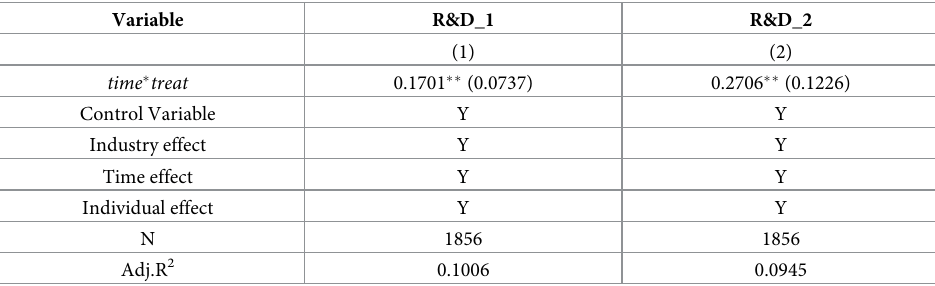
Other robustness tests. There is a large variability in R&D investment among different enterprises, and the overall distribution is right skewed. To reduce the interference of this biased distribution on the results, this paper uses a negative binomial distribution regression to re-estimate the impact of CEO awards on R&D investment. The regression results are reported in columns (1) and (2) of Table 12. We find that the research conclusions of this paper remain valid after considering the right-sided distribution of R&D investment. Further, this paper sets four dummy variables and examines the changes in the R&D investment of enterprises before and after CEOs in the industry receives awards. Ind _ Area [ − 2] indicates that at least one CEO in the industry is given an award for the following two years, and so on, Ind _ Area [+2] indicating that there is a CEO award in the industry for the previous two years. If a CEO award indeed motivates other enterprises in the industry, the coefficients of Ind _ Area [ − 1] and Ind _ Area [ − 2] should not be significant or negative, while the coefficients of Ind _ Area [+1] and Ind _ Area [+2] should be significantly positive. The results in Table 12 show